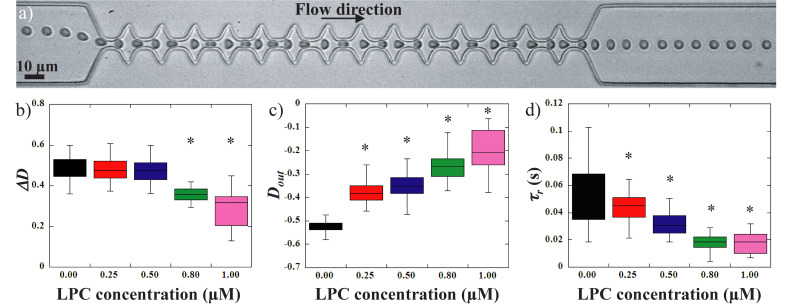
(a) sequence of deformation of a 1 μM LPC treated RBC flowing in the geometry. Evolution of (b) the amplitude of deformation ΔD, (c) the stretching at the exit Dout and (d) the recovery time τr, versus LPC concentration. *Different from control sample (0 μM), p < 0.05.